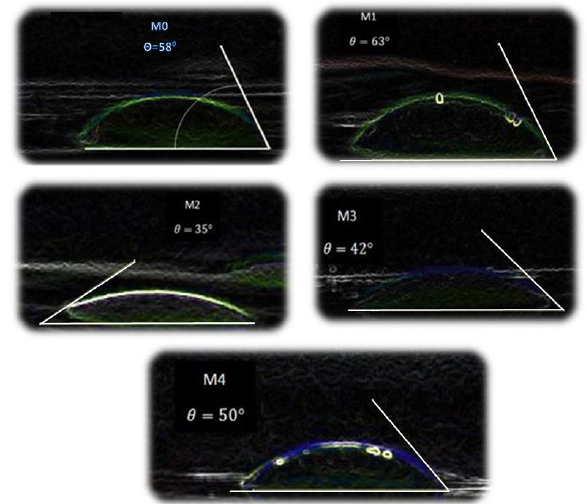
Figure 2. Contact time of the polysulfone membranes modified with different percentages of ZnO